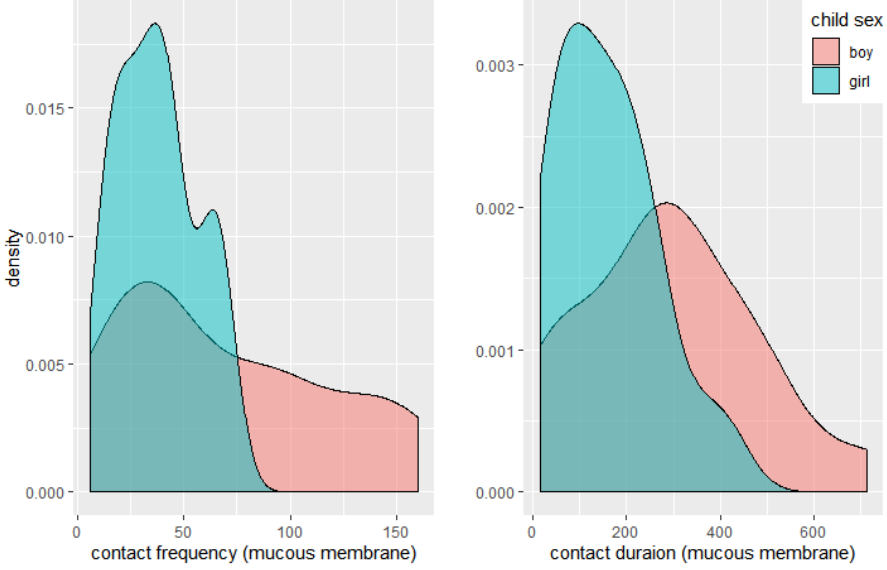
Figure 3. Density distribution of frequency and duration in hand-to-face contact by gender. Density of contact frequency = number/contact frequency-group width; Density of contact duration = number/contact duration-group width.